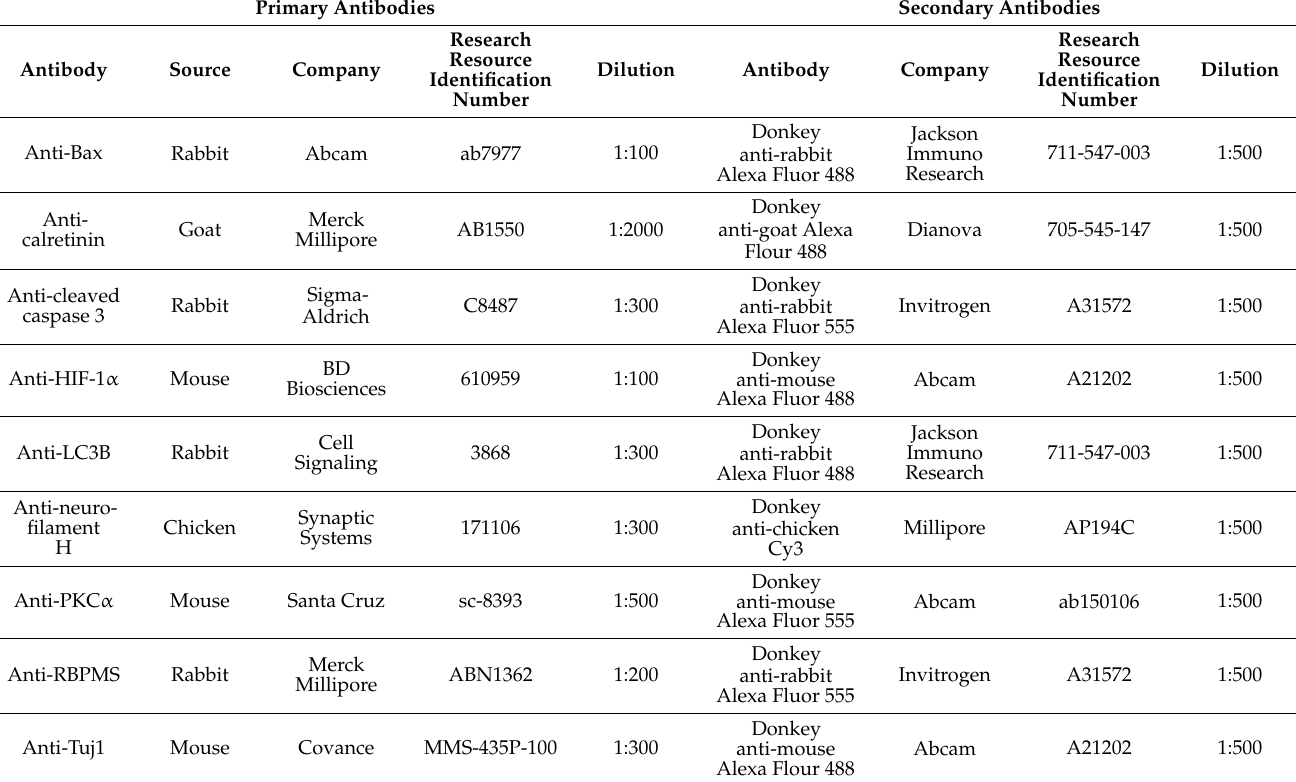
Table 1. Primary and secondary antibodies used for